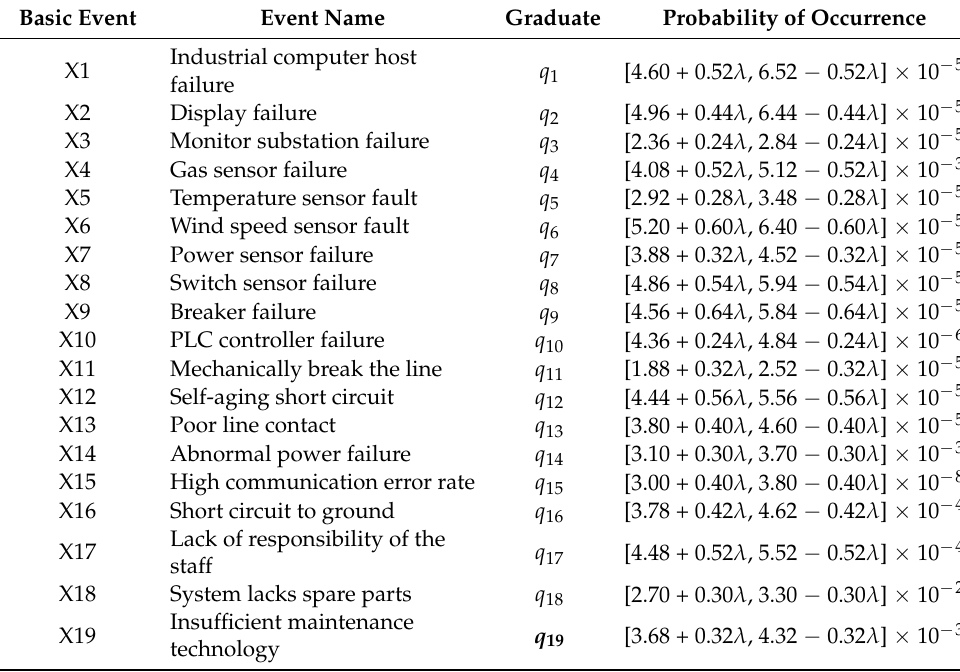
Table 3. Probability of occurrence of the fault tree event